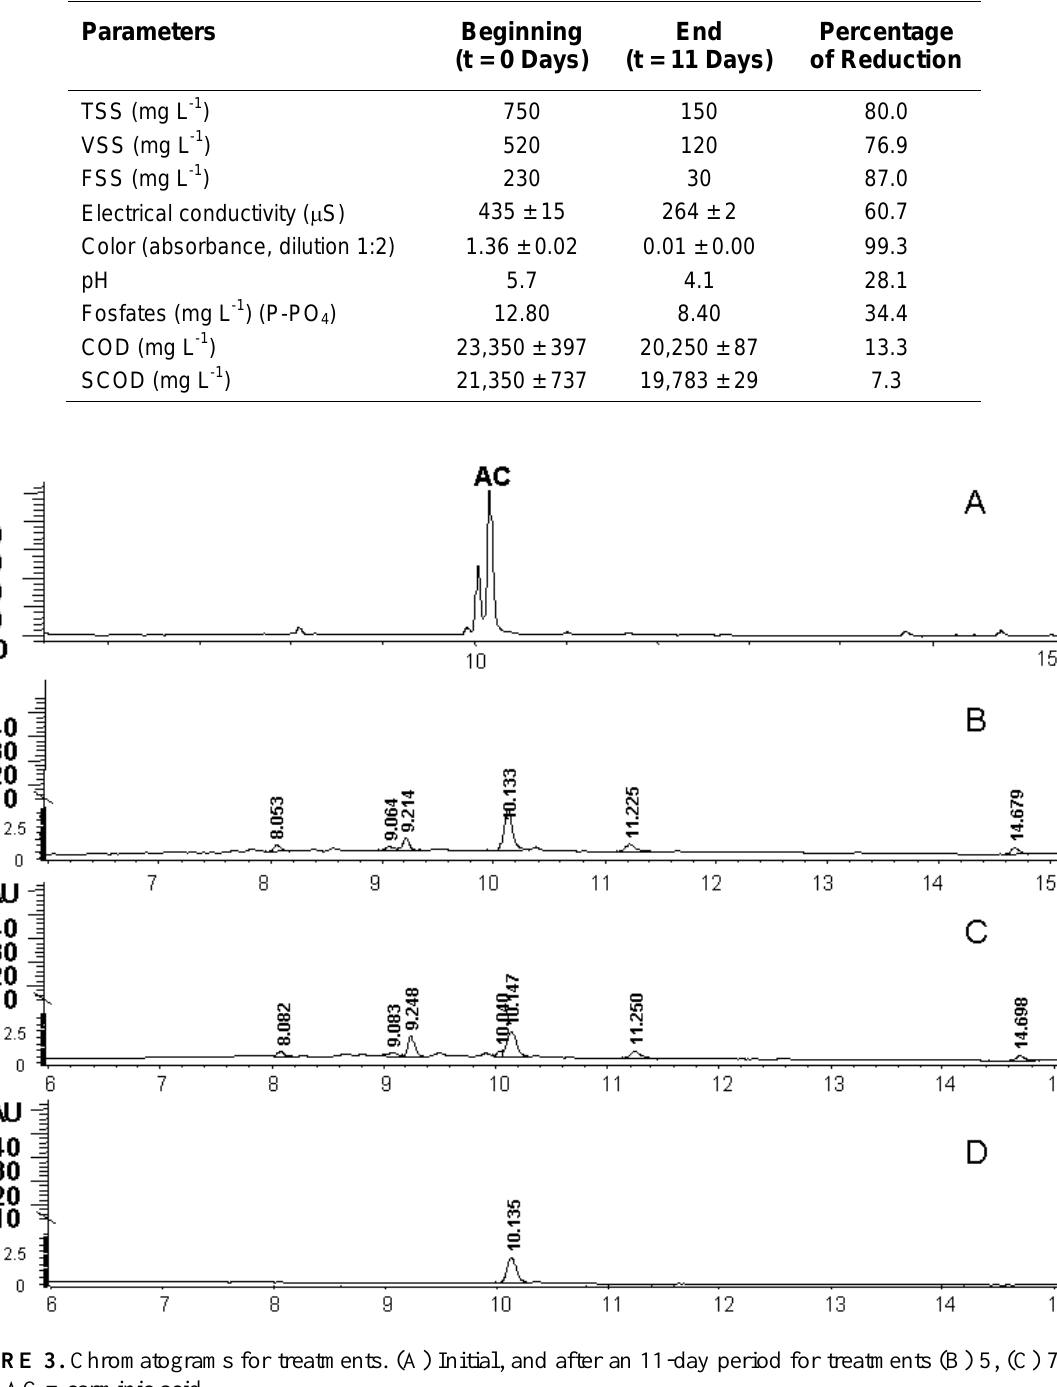
Characterization of the Effluent from the Cotton Dyeing Process with Cochineal Extract at the Beginning and at the End of Treatment 8 with Tv Fungus